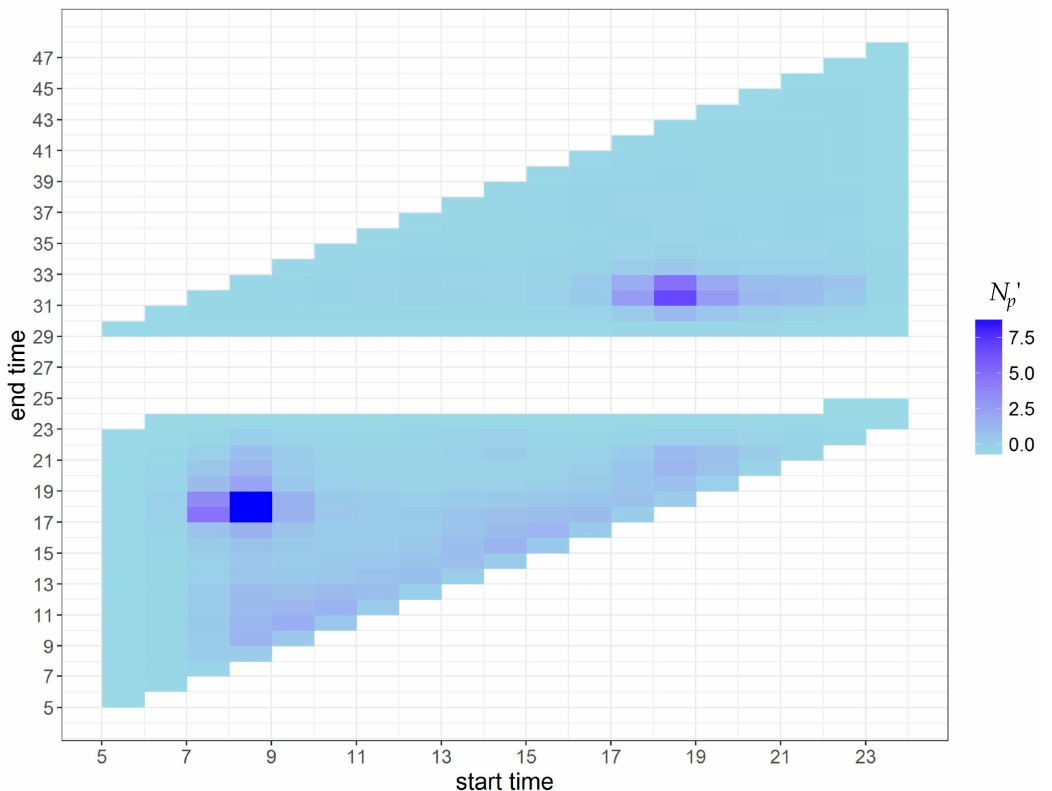
Figure 3. The distribution of staying activity duration (bin width = 1).